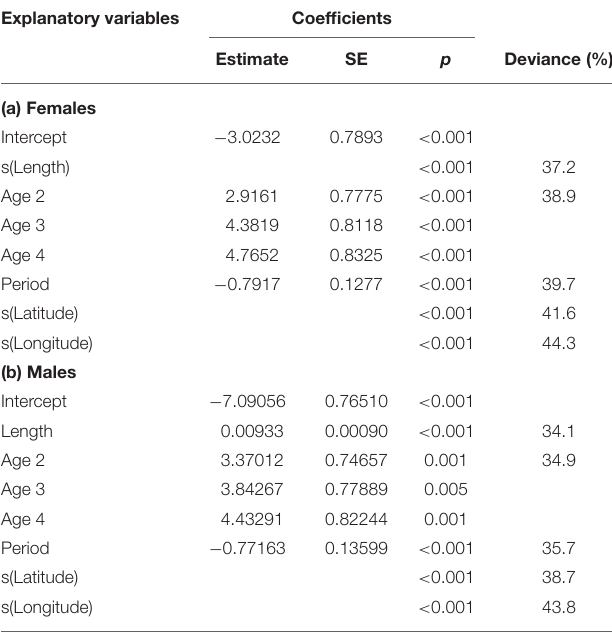
TABLE 3 | GAM model coefficients and deviance explained for sex-related maturity in relation to length, age, period (decade), longitude, and latitude. Explanatory